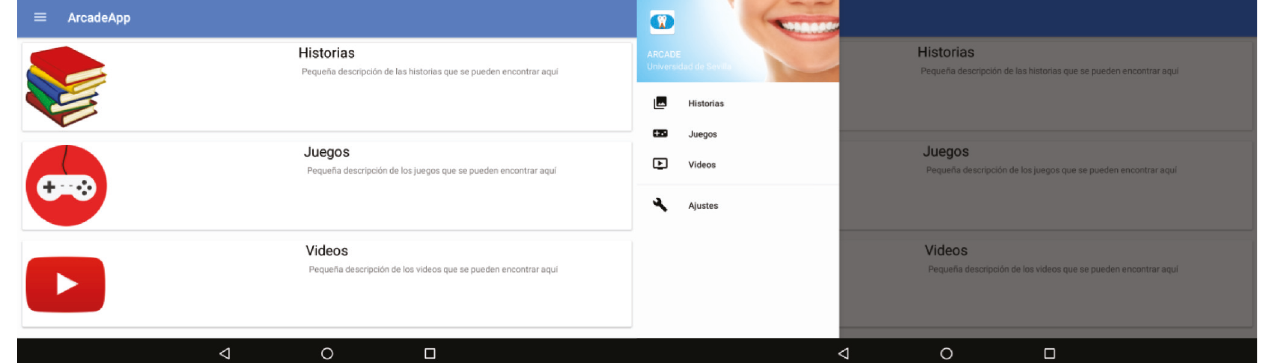
Figure 25: Main menu.